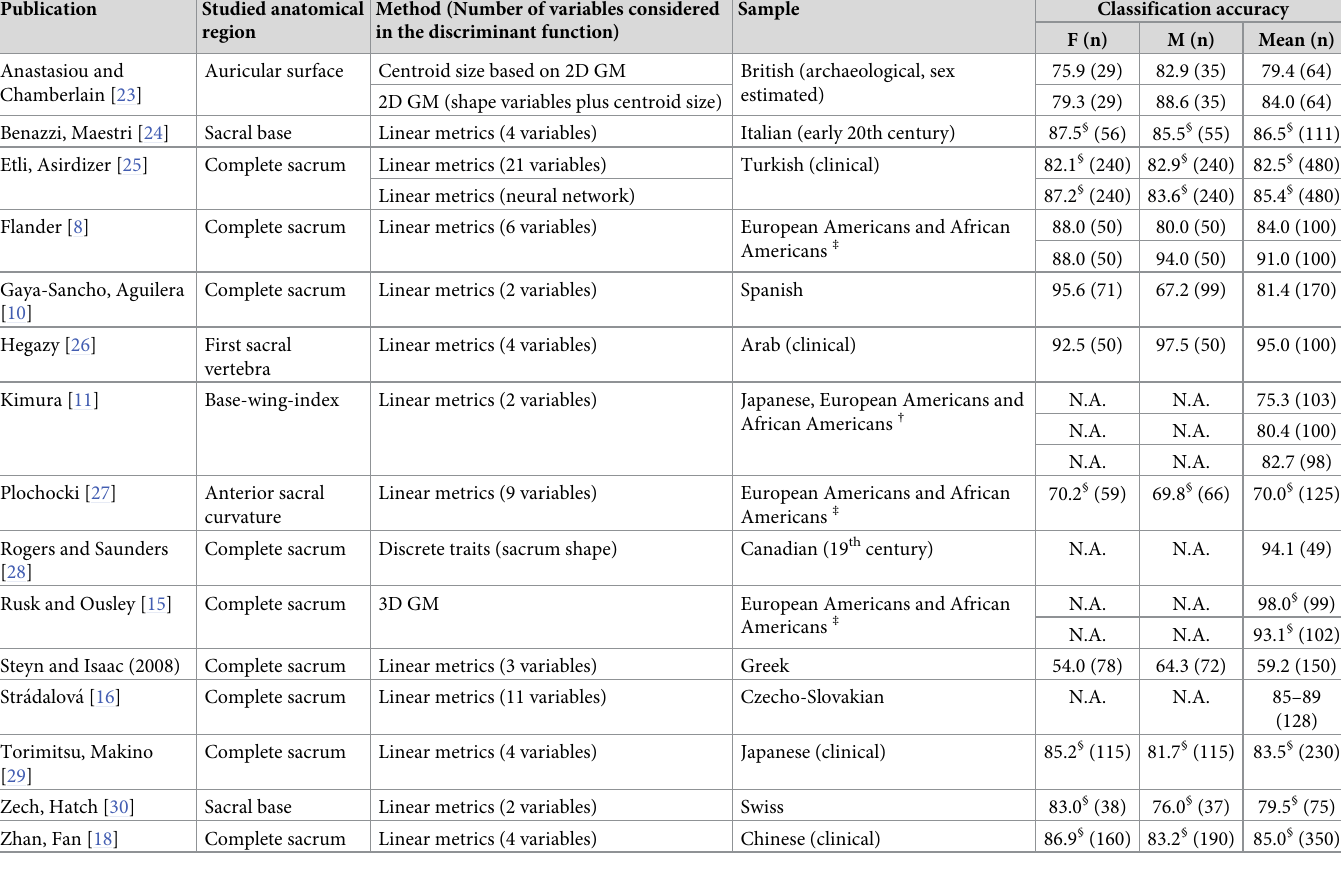
Table 1. Previously published classification accuracies (%) for sex determination based on the modern human